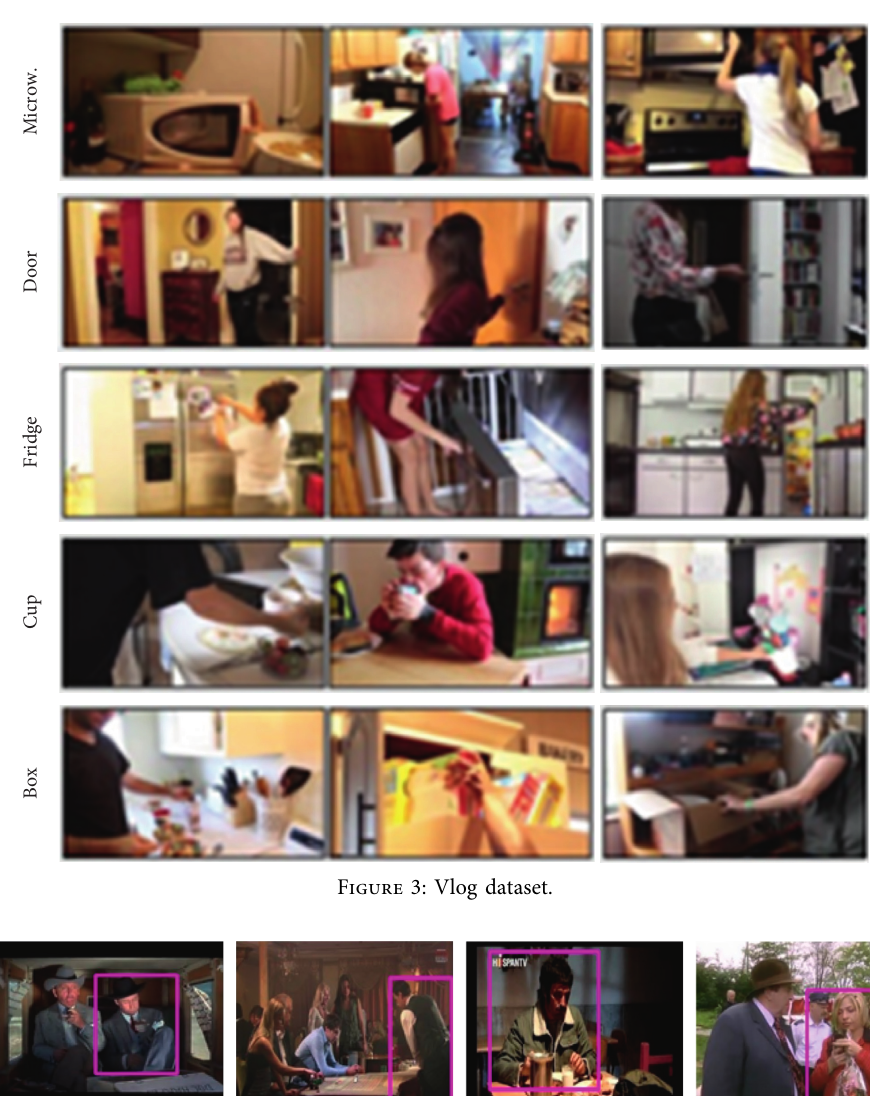
Figure 4: AVA dataset (random